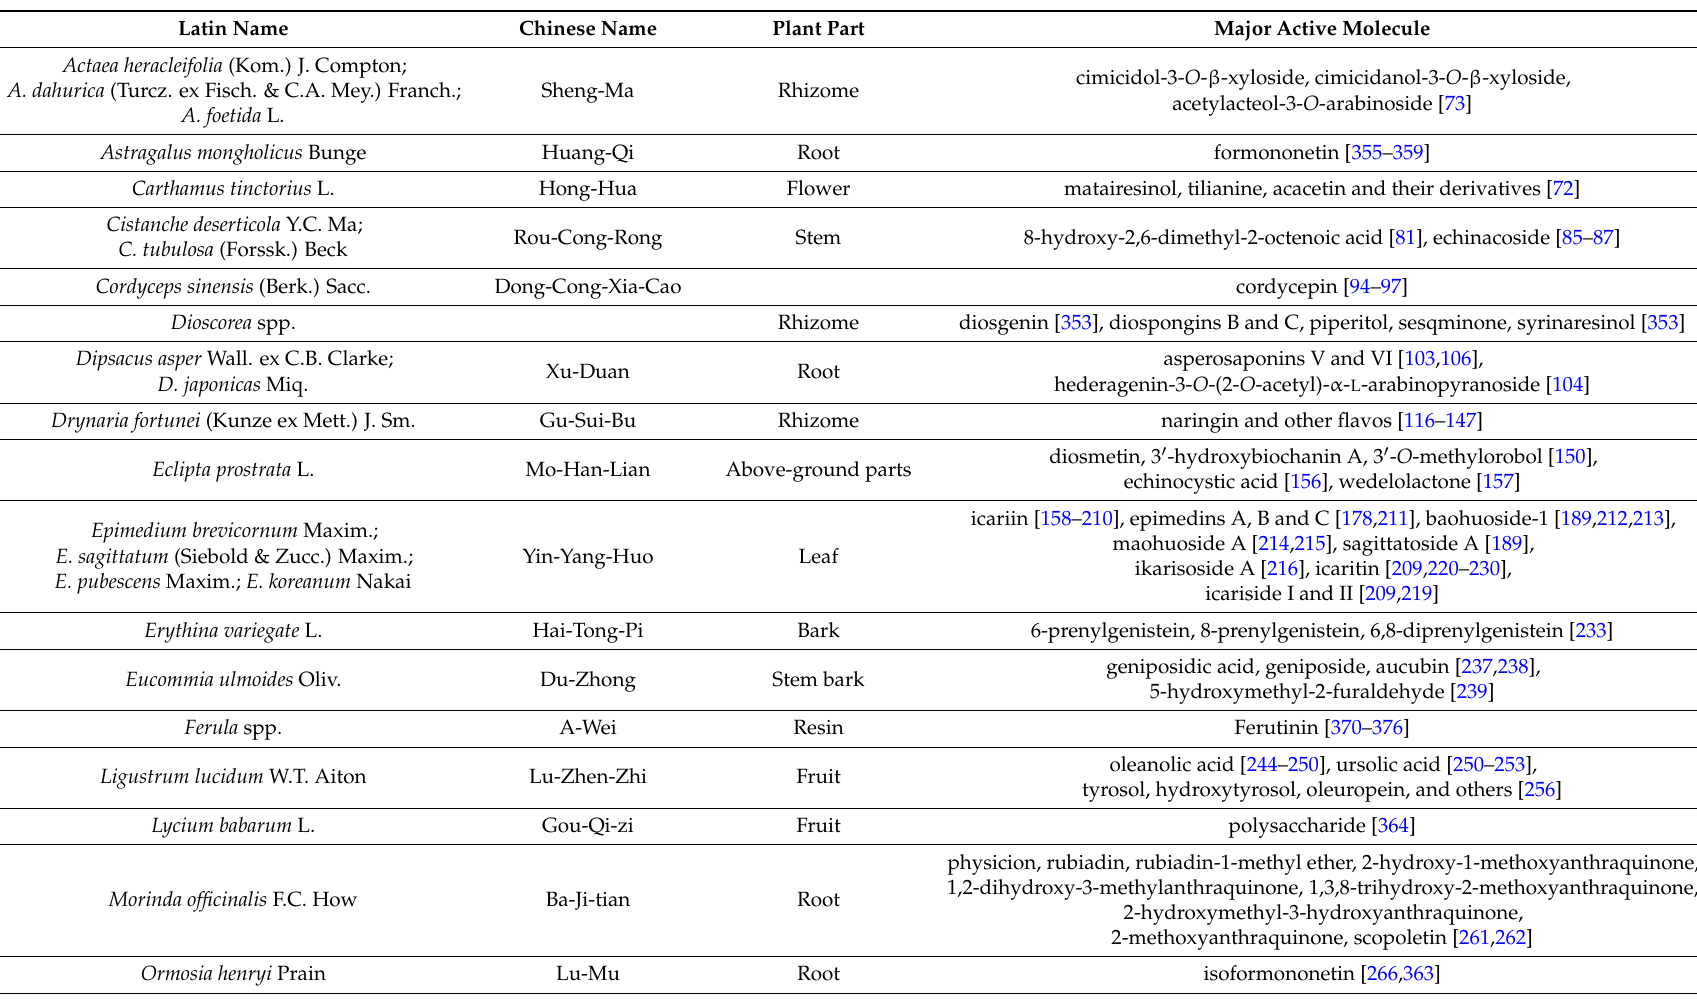
Table 2. Botanical sources of natural products from Chinese medicinal herbs showing osteoprotective